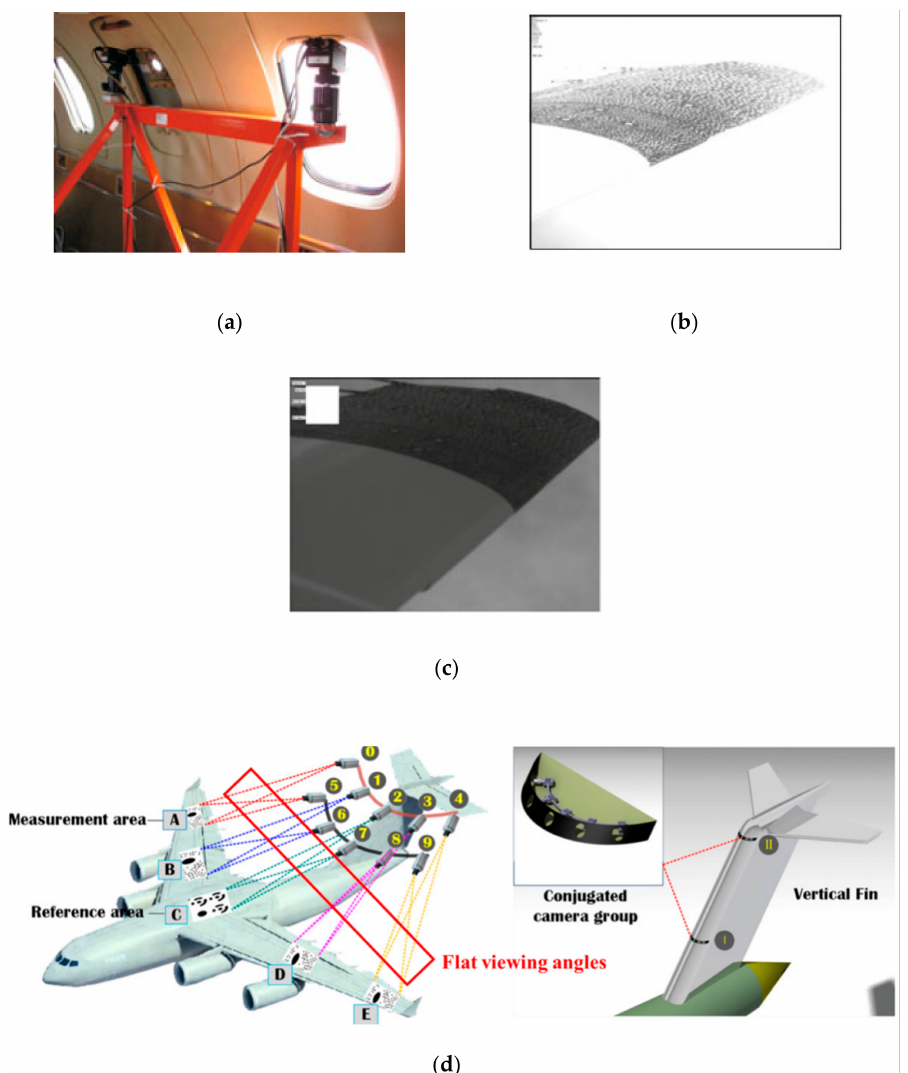
Figure 2. Vision system for an in-flight wing deformation measurement [54,55]: ( a ) the camera installed in the passenger compartment; ( b ) overexposure of the images owing to the changing illumination during the in-flight recording; ( c ) underexposure of the images; ( d ) the camera installed on the vertical fin for observing the wing speckle pattern and coded targets. Both of the two cases undergo flat viewing angles.